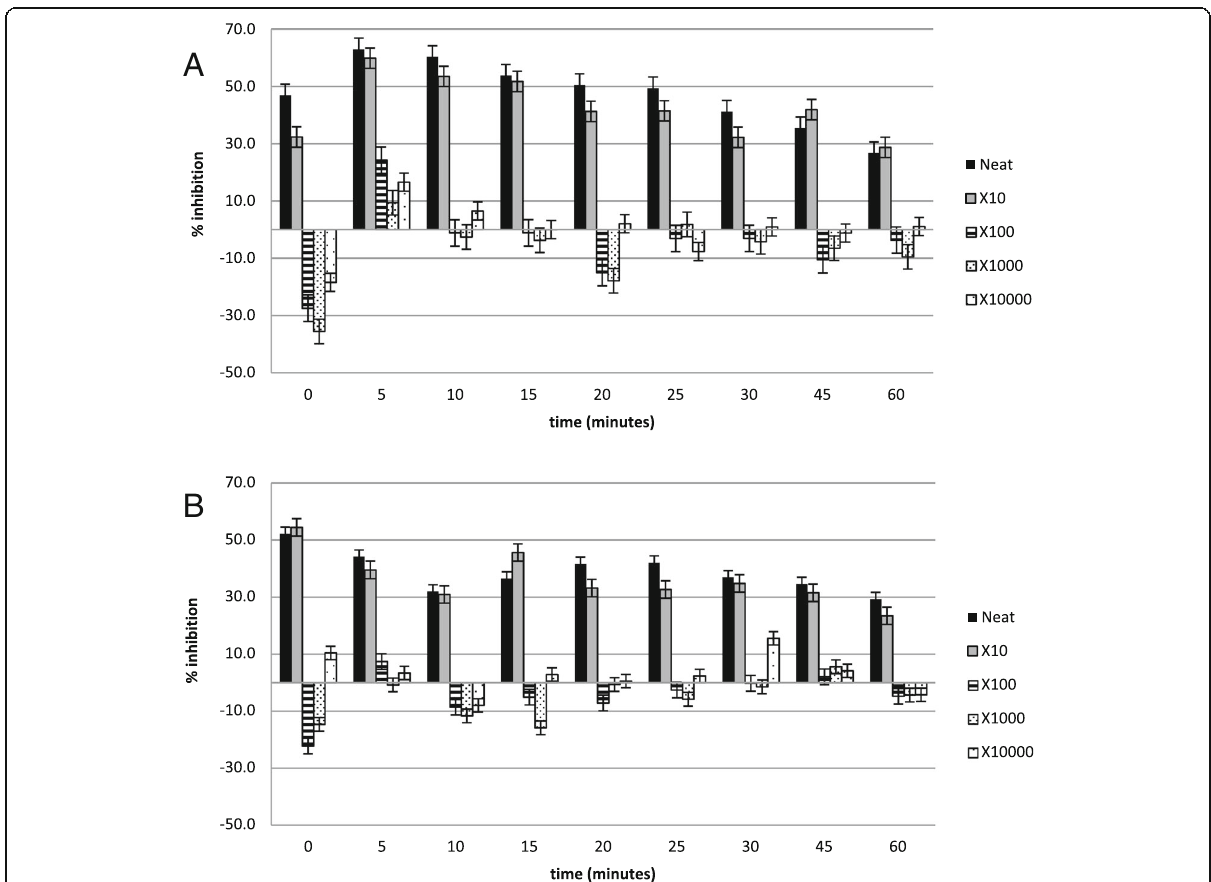
Fig. 5 The % inhibition of healthy platelets after incubation with the HM4 and diluted standards, and activation with ( a ) fMLP and ( b )